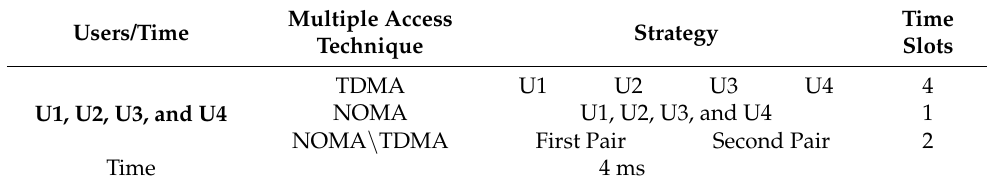
Table 3. Hybrid-NOMA